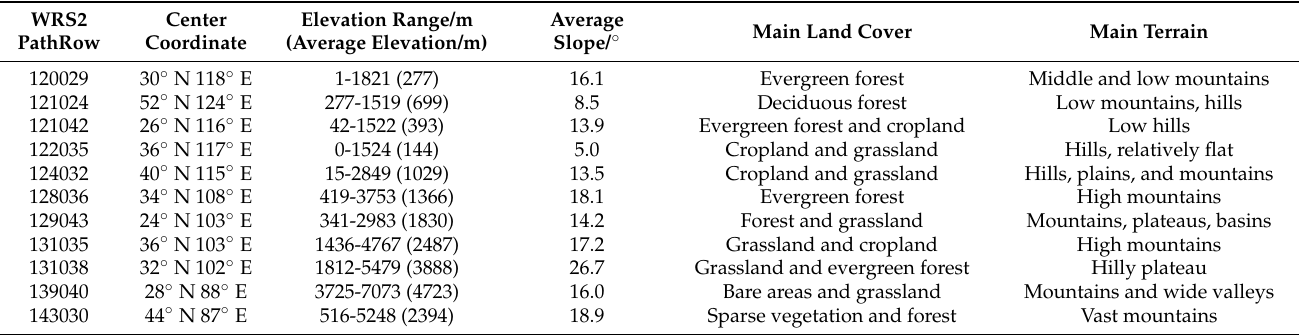
Figure 1. The study area location with DEM of China (the red box is the study area we used which contains different terrain conditions and the number in the red box represents the number of scenes). Table 2. Terrain parameter statistics of Landsat data selected in the study